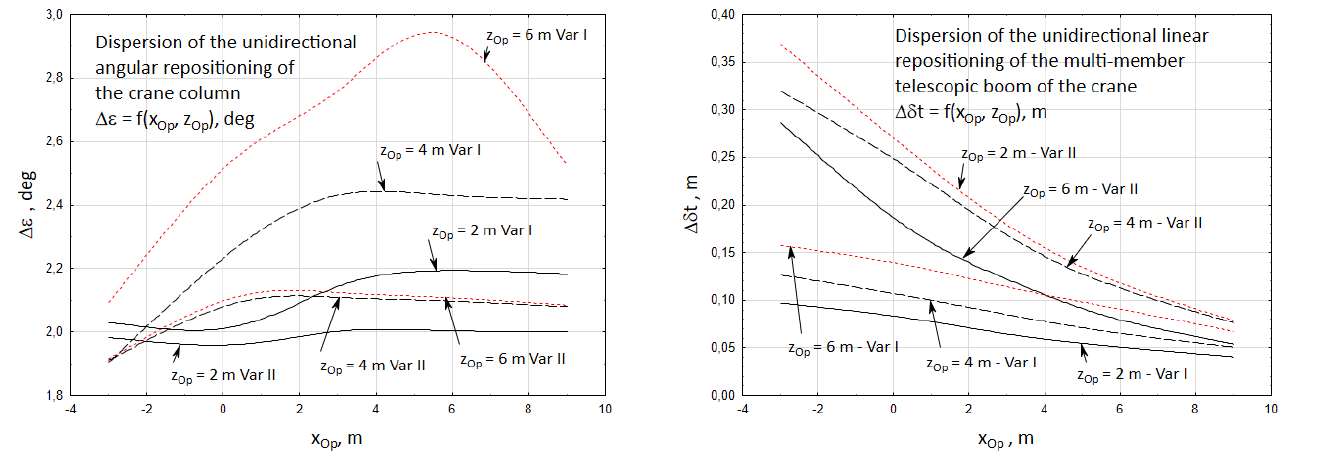
Figure 15. Accuracy of the unidirectional positioning of the cargo.